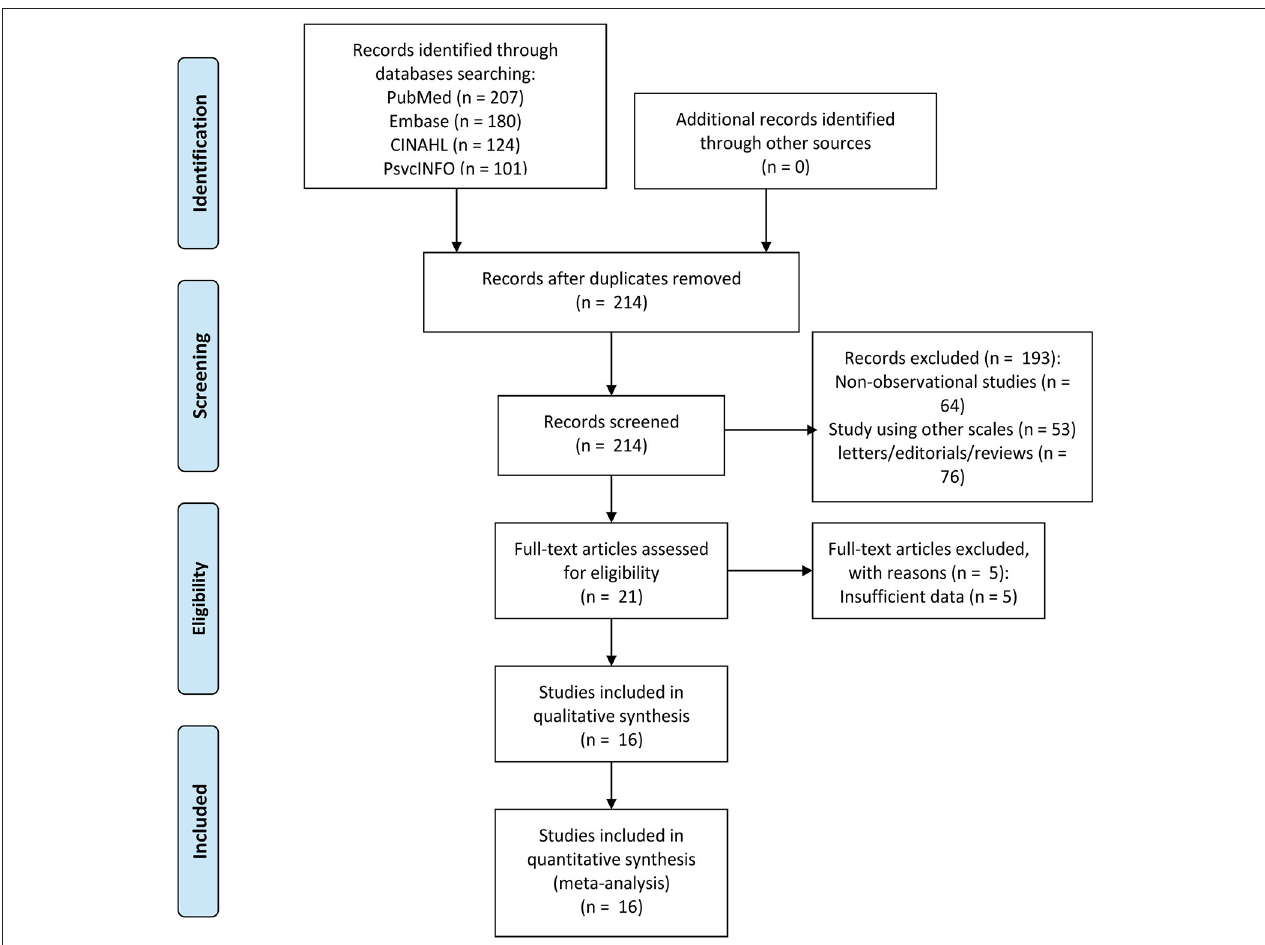
FIGURE 1 | Flowchart of selecting and screening